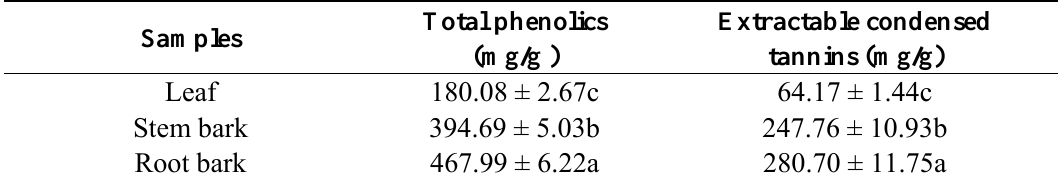
Table 1. Contents of total phenolics and extractable condensed tannins in leaf, stem bark and root bark of A. confusa